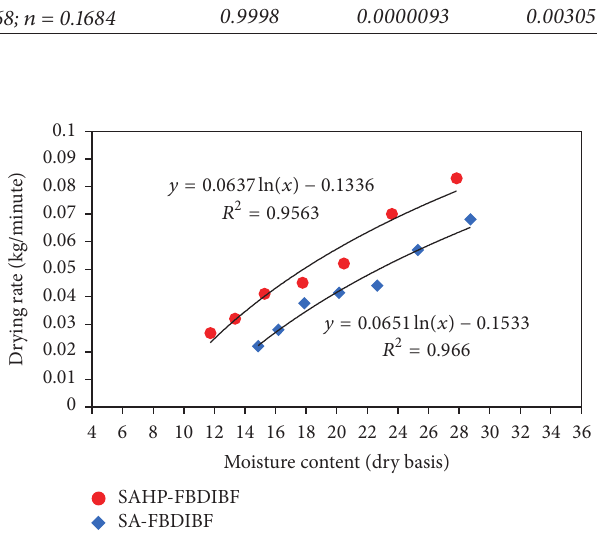
Figure 28: The variation of drying rate with moisture content dry